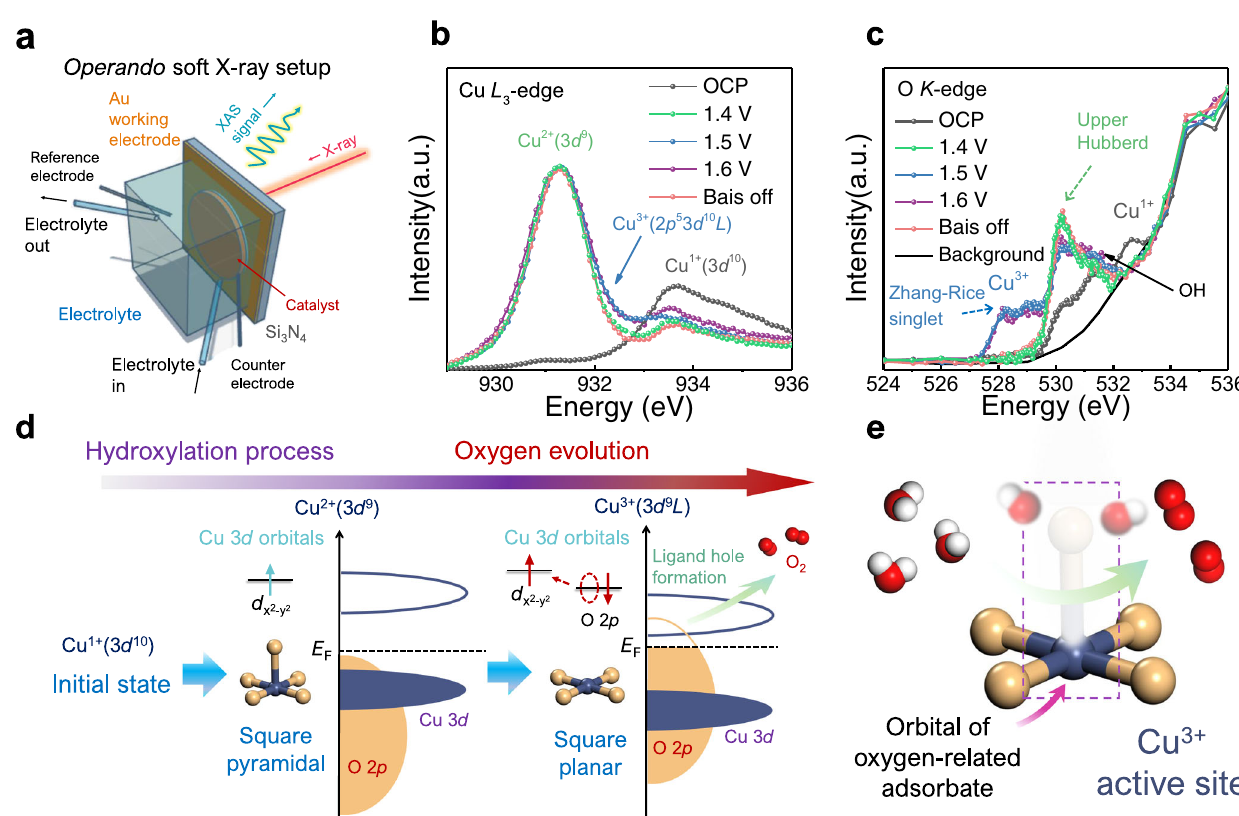
Fig. 4 | Operando soft-XAS characterization of high-valent Cu as an active site during OER. a Schematic illustration of operando soft-XAS setup under ultrahigh vacuumcondition. b Cu L 3 -edgeand c O K -edge ofH-Cu 2 O. d